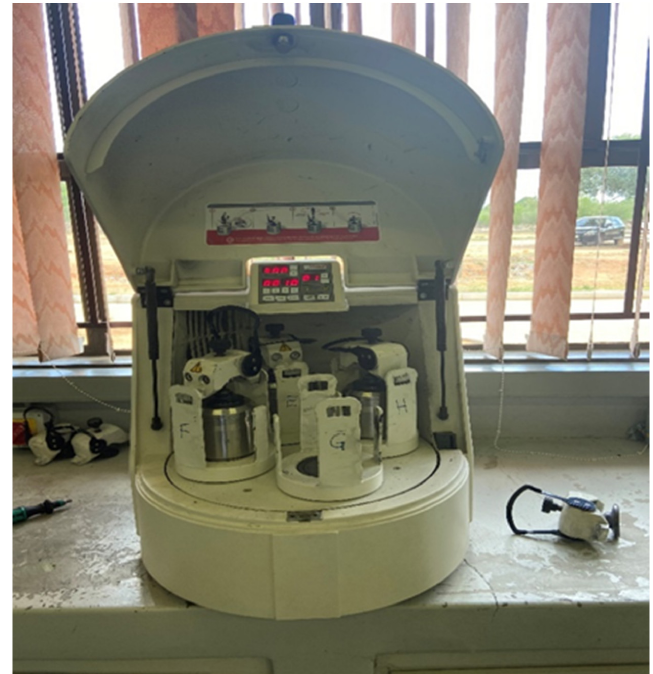
Figure 2. Planetary ball mill used for comminution.